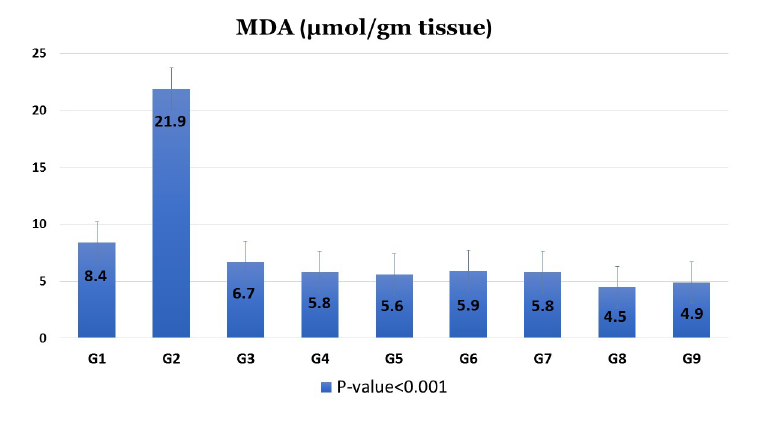
Fig 4. Effect of different treatment regimens included in the study on liver MDA level of S . mansoni infected mice groups sacrificed at 10 th week PI. Values are given as mean ± SD for 4 mice in each group. Values show high significant difference ( P < 0.001).